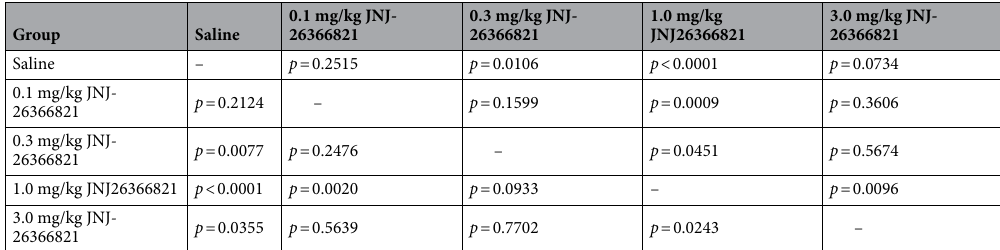
Table 1. Comparison of Log-Rank (top) and Fisher’s exact test (bottom) statistical analyses for Fig. 2A. Above the diagonal of non-comparison where groups would be compared with themselves are significance values for log-rank analysis of the survival curves. Below the diagonal are significance values for Fisher’s exact test conducted based on surviving proportions on day 30.